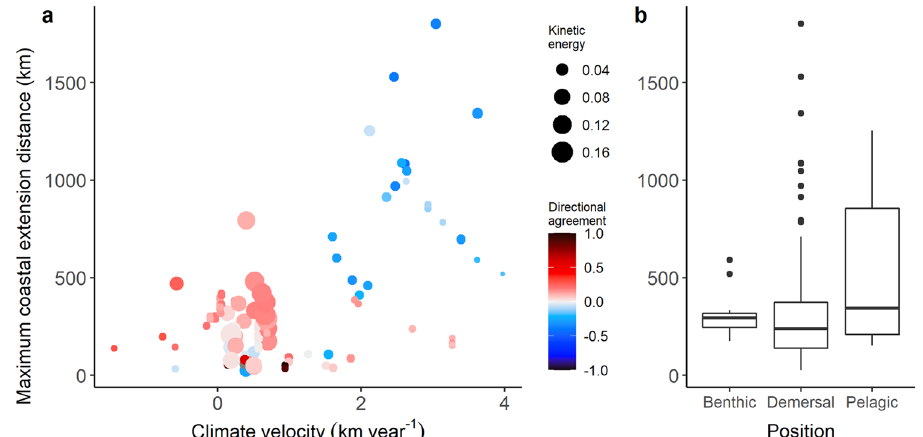
Fig. 5 Relationships between observed maximum annual extension distances along the coast and the predictor variables retained in the fi nal model. a Scatterplot of extension distance and climate velocity with colors and size of the points showing the directional agreement between climate velocity, ocean currents and current strength, respectively. b Box plots (center line, median; box limits, 75th and 25th percentiles; whiskers, 1.5× interquartile range; points, outliers) of extension distance grouped by position in the water column of the species. n = 127 maximum annual extension